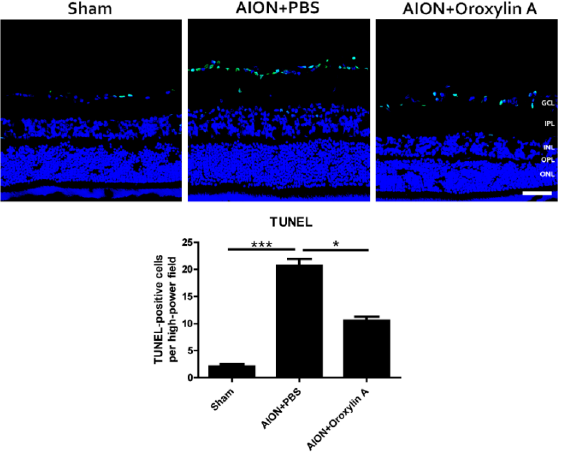
Figure 6. TUNEL assay in the retinal sections after rAION in each group. After ischemic injury, rats treated with OA showed significantly less TUNEL+ cells (green) than rats treated with PBS (10.6 ± 2.4 versus 20.7 ± 3.9 cells/HPF, respectively). Results represent the means ± SDs. Scale bar, 50 μ m; * p ≤ 0.05, *** p ≤ 0.001; n = 6. GCL: ganglion cell layer; IPL: inner plexiform layer; INL: inner nuclear layer; OPL: outer plexiform layer; ONL: outer nuclear layer.